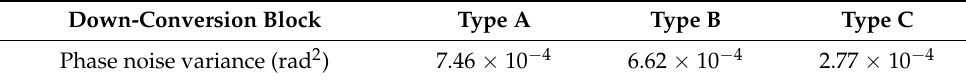
Figure 8. The measured phase noise spectrum. Table 1. The phase noise variance of the three types of down-conversion blocks.